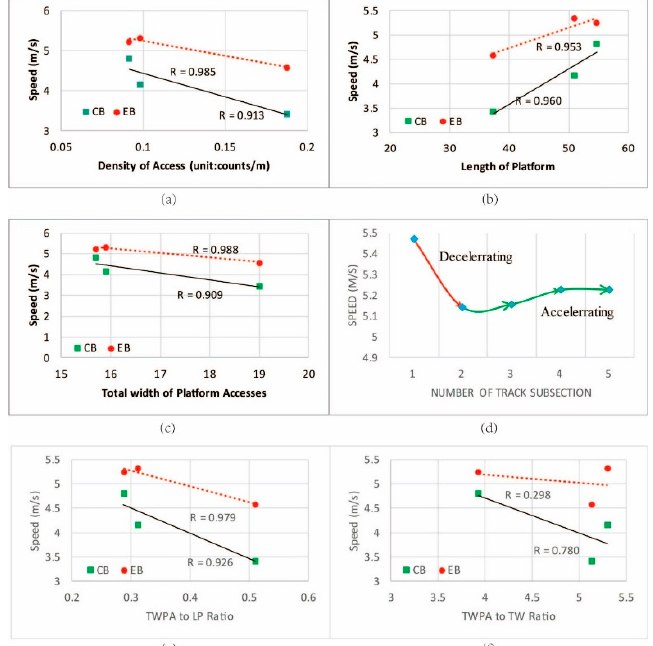
Figure 4. ( a ) Relationships between Bicycle Speed and Density of Platform Access; ( b ) Relationships between Bicycle Speed and Platform Length; ( c ) Trend of Mean of bike Speed travelling through bypass of Gulou Stop; ( d ) Relationships between Bicycle Speed and Total width of Platform Accesses; ( e ) Relationships between Bicycle Speed and total width of platform accesses-to platform length (TWPA-to-PL) Ratio; ( f ) Relationship between Bicycle Speed and TWPA-to-total width (TW) Ratio.